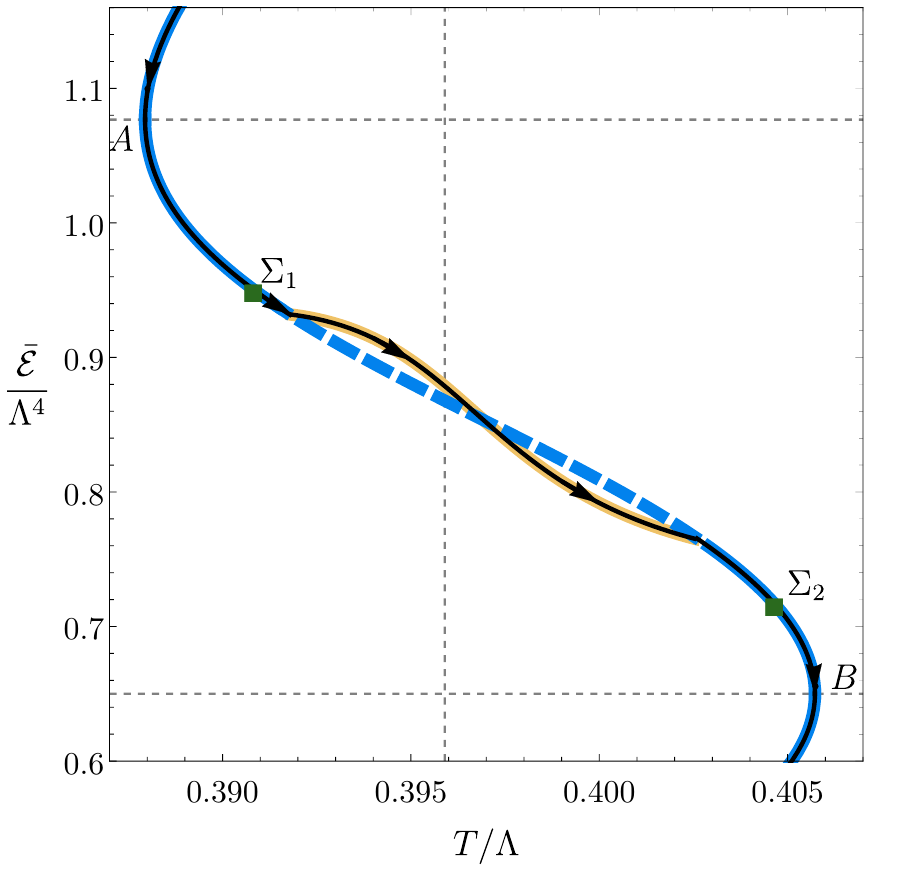
Figure 30 . Phase diagram in the microcanonical ensemble for a length ˆ L ’ 5 . 299674 such that ˆ L ˆ L < ˆ L ˆ L K < Σ 1 < Σ 2 . The blue and the beige curves correspond to homogeneous and inhomoge- neous states, respectively. The beige curve is the same as the curve of beige inverted triangles in fig- ure 11. Solid segments indicate locally dynamically stable states; dashed segments indicate unstable ones. The black curves with arrows indicate the sequence of globally preferred, maximum-entropy states as the average energy density decreases. The phase transitions between the homogeneous and the inhomogeneous branches take place at the points where these branches merge and they are